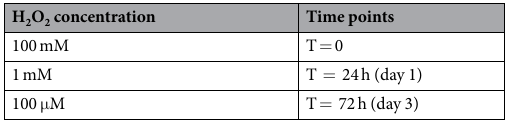
Table 1. ROS-mimicking conditions (left) and time points of assessment